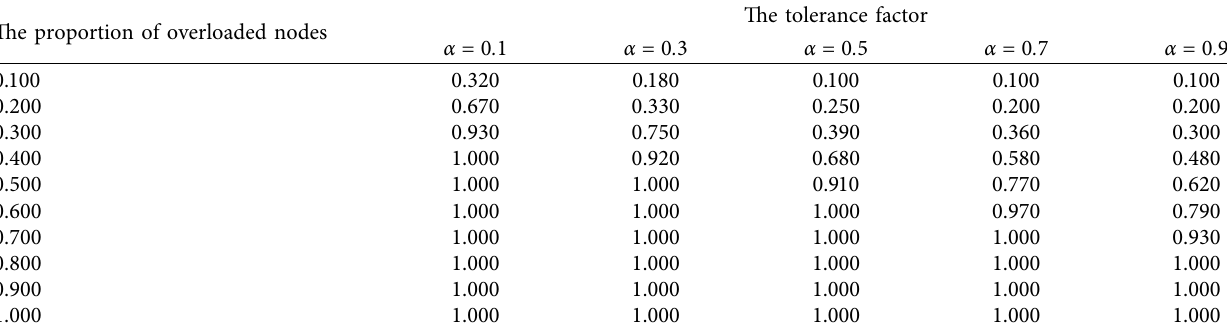
Table 8: The proportion of abnormal nodes